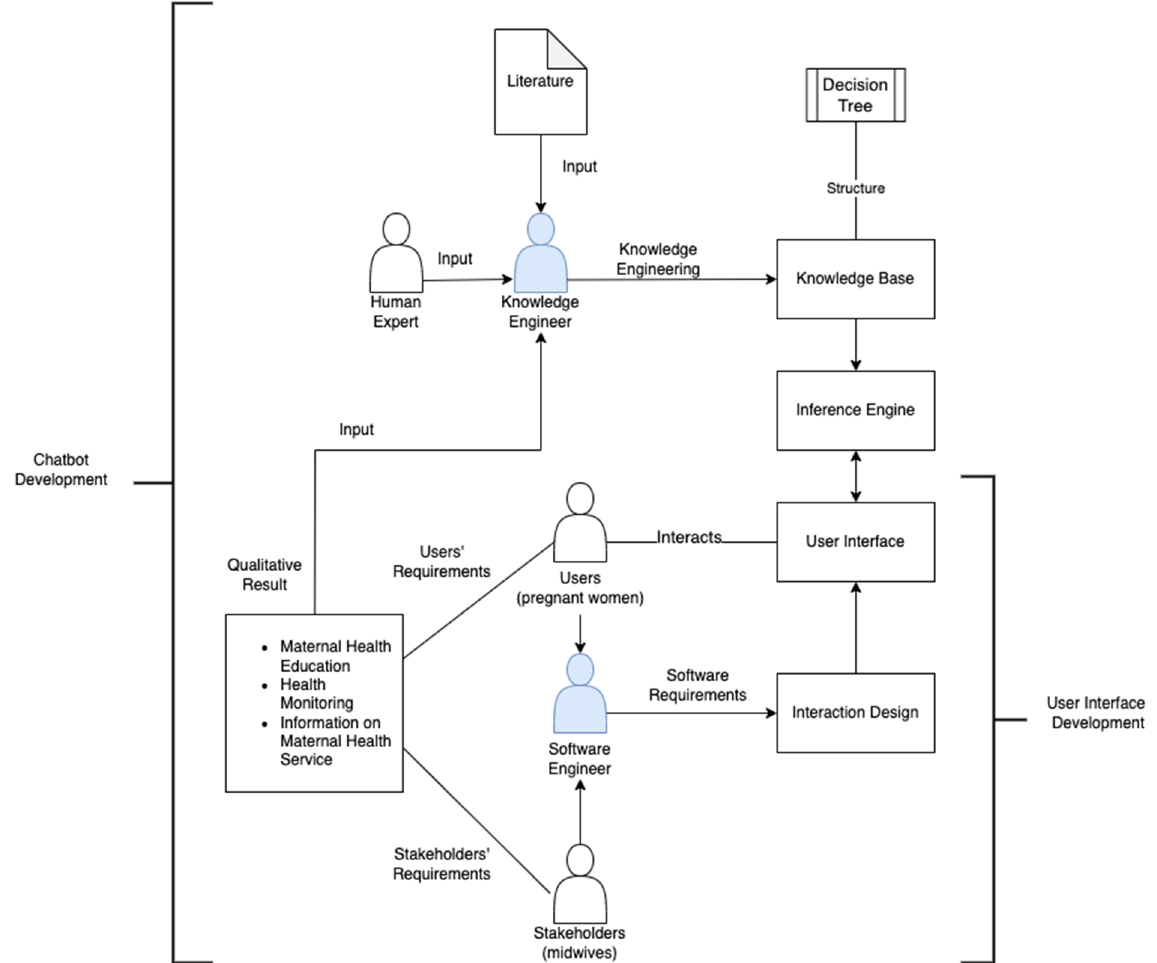
Figure 7. The process of chatbot and its user interface development.